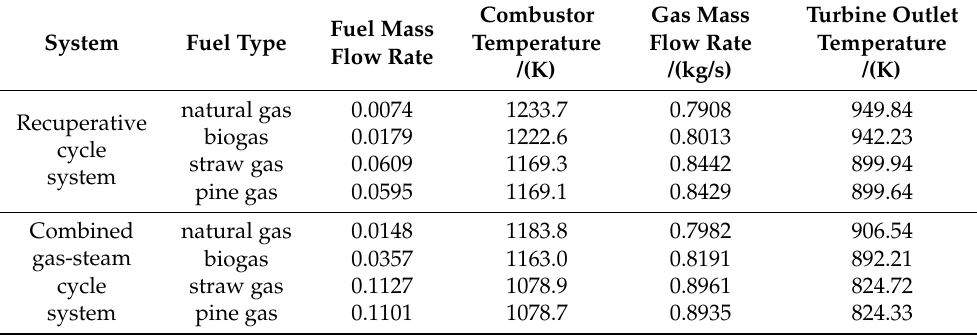
Table 5. Combined cycle operating parameters of different types of